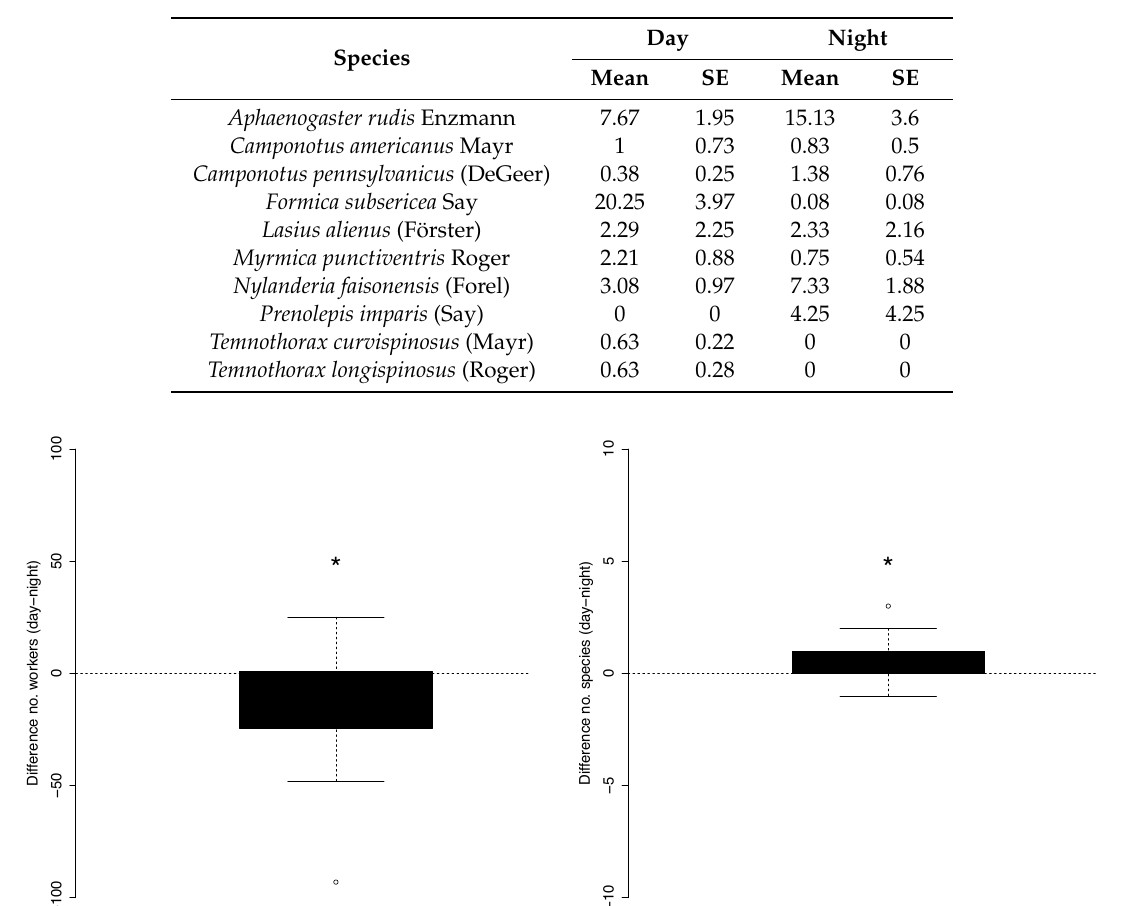
Table 6. Mean number of workers ( ± SE) recorded at baits during the day and at night.